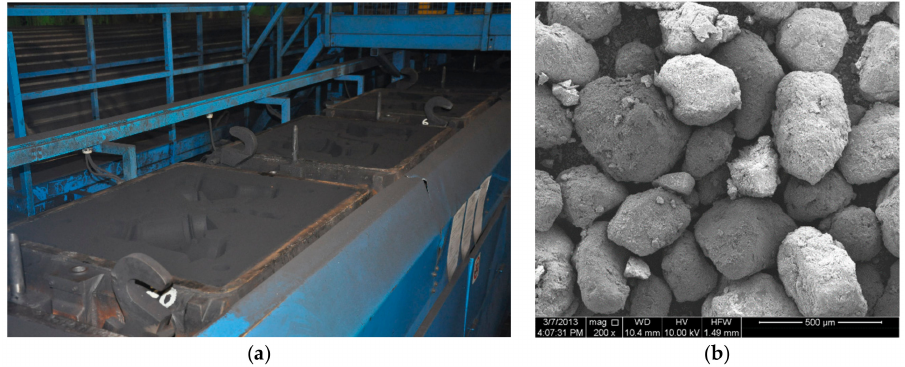
Figure 1. ( a ) Foundry sand as mould in iron casting; ( b ) Microstructure of waste foundry sand (WFS).